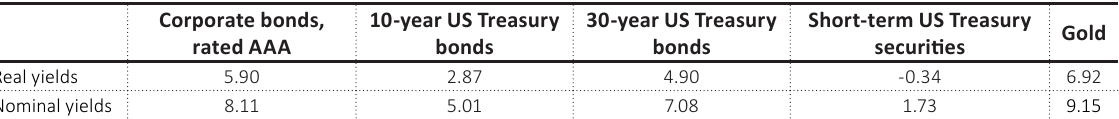
Table 3. Nominal and real interest rates of different assets in the USA in 1999–2020, per annum Source: Compiled by the authors based on Deutsche Bank